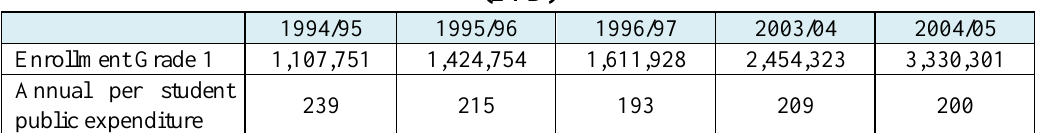
Table 5-4: Annual per Student Public Expenditure (1994/95 - 1996/97, 2003/04,